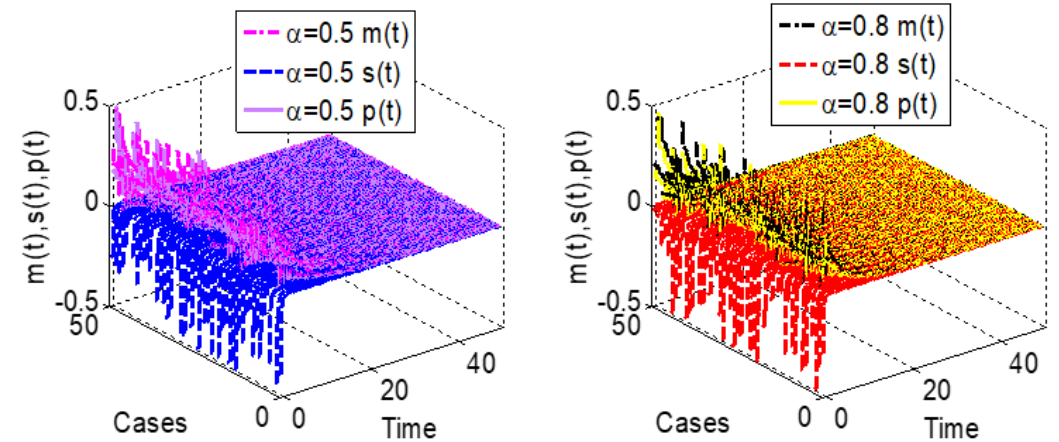
Figure 10. Time response of the three-dimension FOGRN when 0.5. τ =